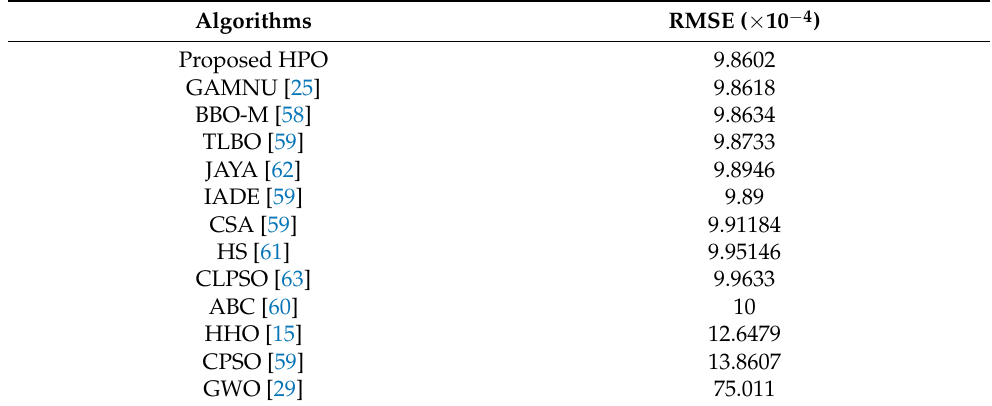
Table 10. Comparative assessment of HPO for the single-diode model of RTC France versus reported optimizers.